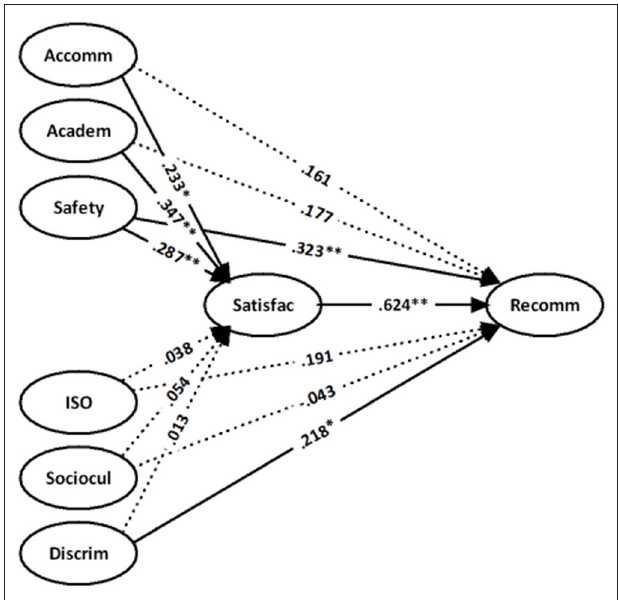
FIGURE 4 | Sample from developed regions [country code = (3 + 4 + 5) 3] with controls for gender and